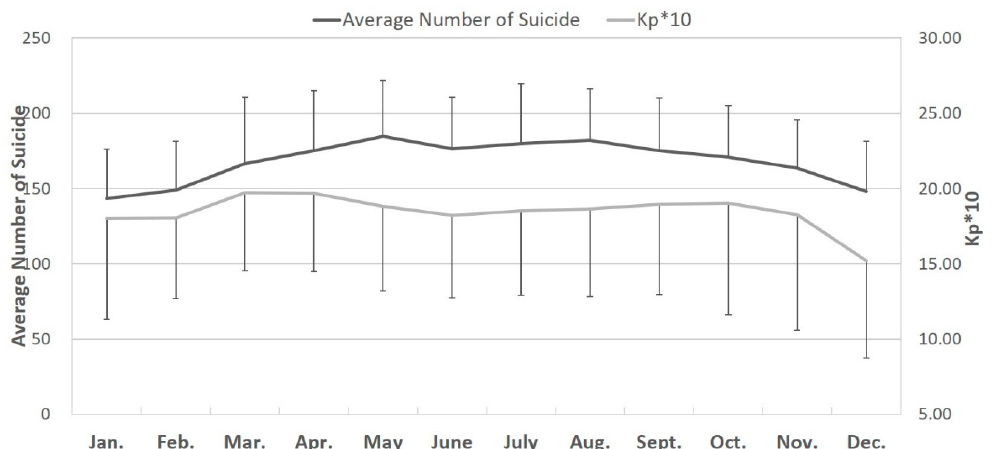
Figure 1. Changes in the monthly number of male suicide attempts and monthly Kp10 values from January 1997 to December 2013.